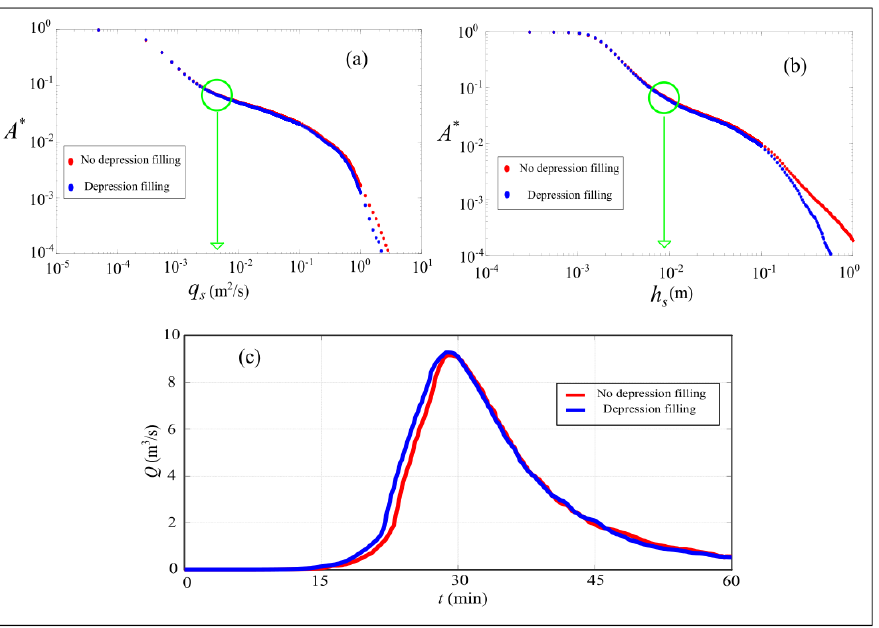
Figure 4. Luvinate watershed: effects of the depression filling on both the A* - q s ( a ) and A*-h s ( b ) curves and the simulated discharges ( c